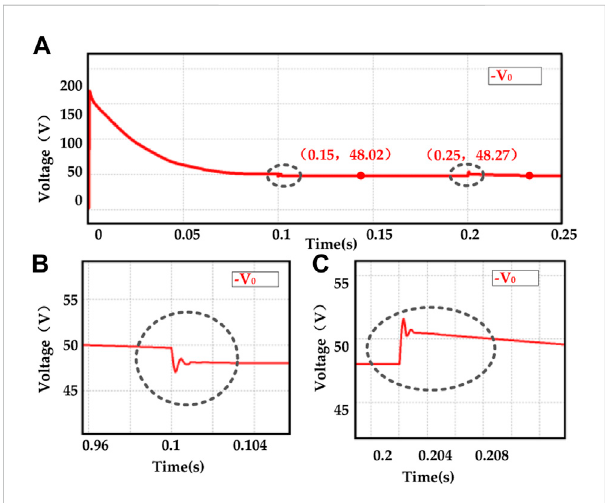
FIGURE 12 The waveform of output voltage. (A) is the overview waveform; (B) is the detail waveform when the resistor changes; (C) is the detail waveform when the input voltage changes.